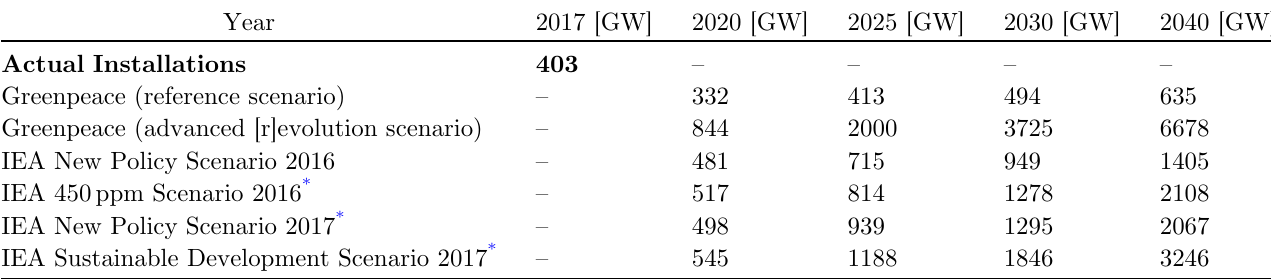
Table 1. Evolution of the cumulative solar electrical capacities until 2050